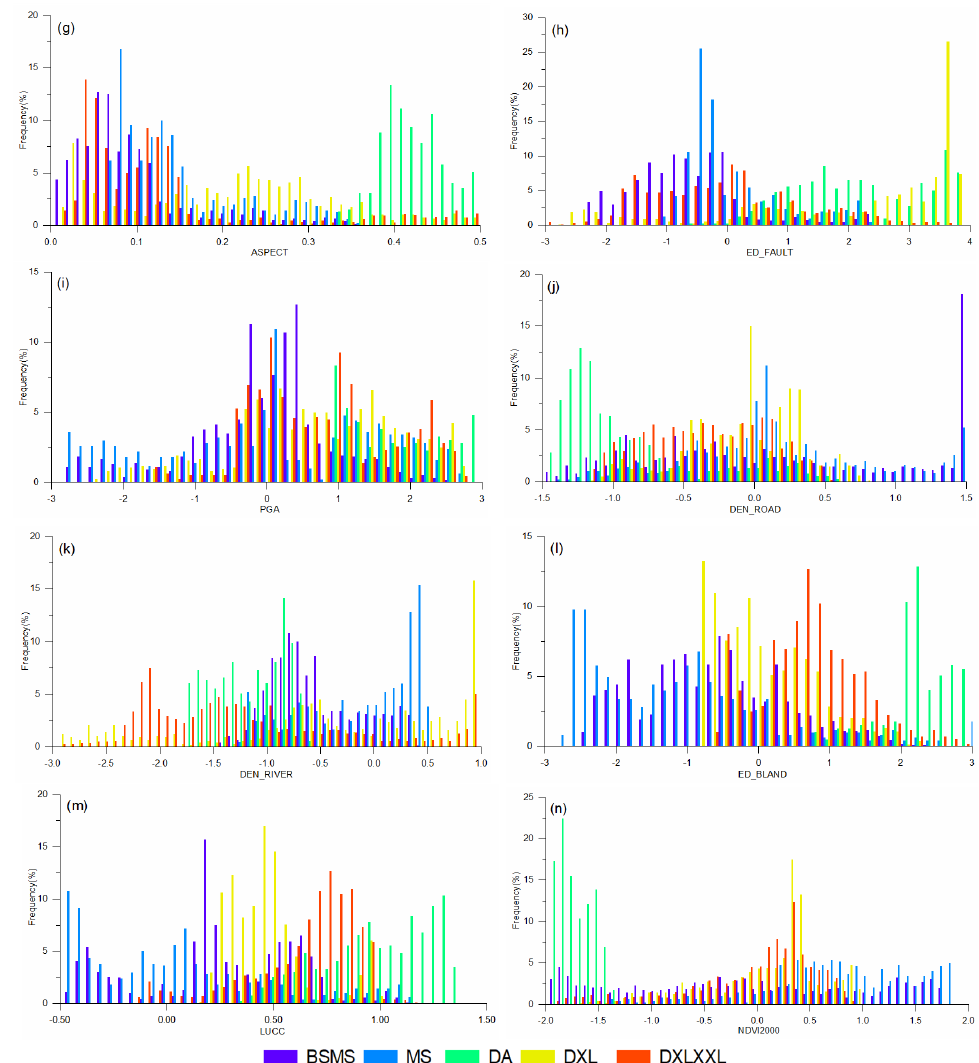
Figure A3. Histogram of estimated coefficients for each factor in different partitions. ( a ) Temperature mean value; ( b ) temperature slope value; ( c ) precipitation mean value; ( d ) precipitation slope value; ( e ) elevation; ( f ) slope; ( g ) aspect; ( h ) Euclidean distance from fault; ( i ) peak ground acceleration; ( j ) road density; ( k ) river density; ( l ) Euclidean distance from built-up land; ( m ) land-use change index; ( n ) NDVI in 2000.